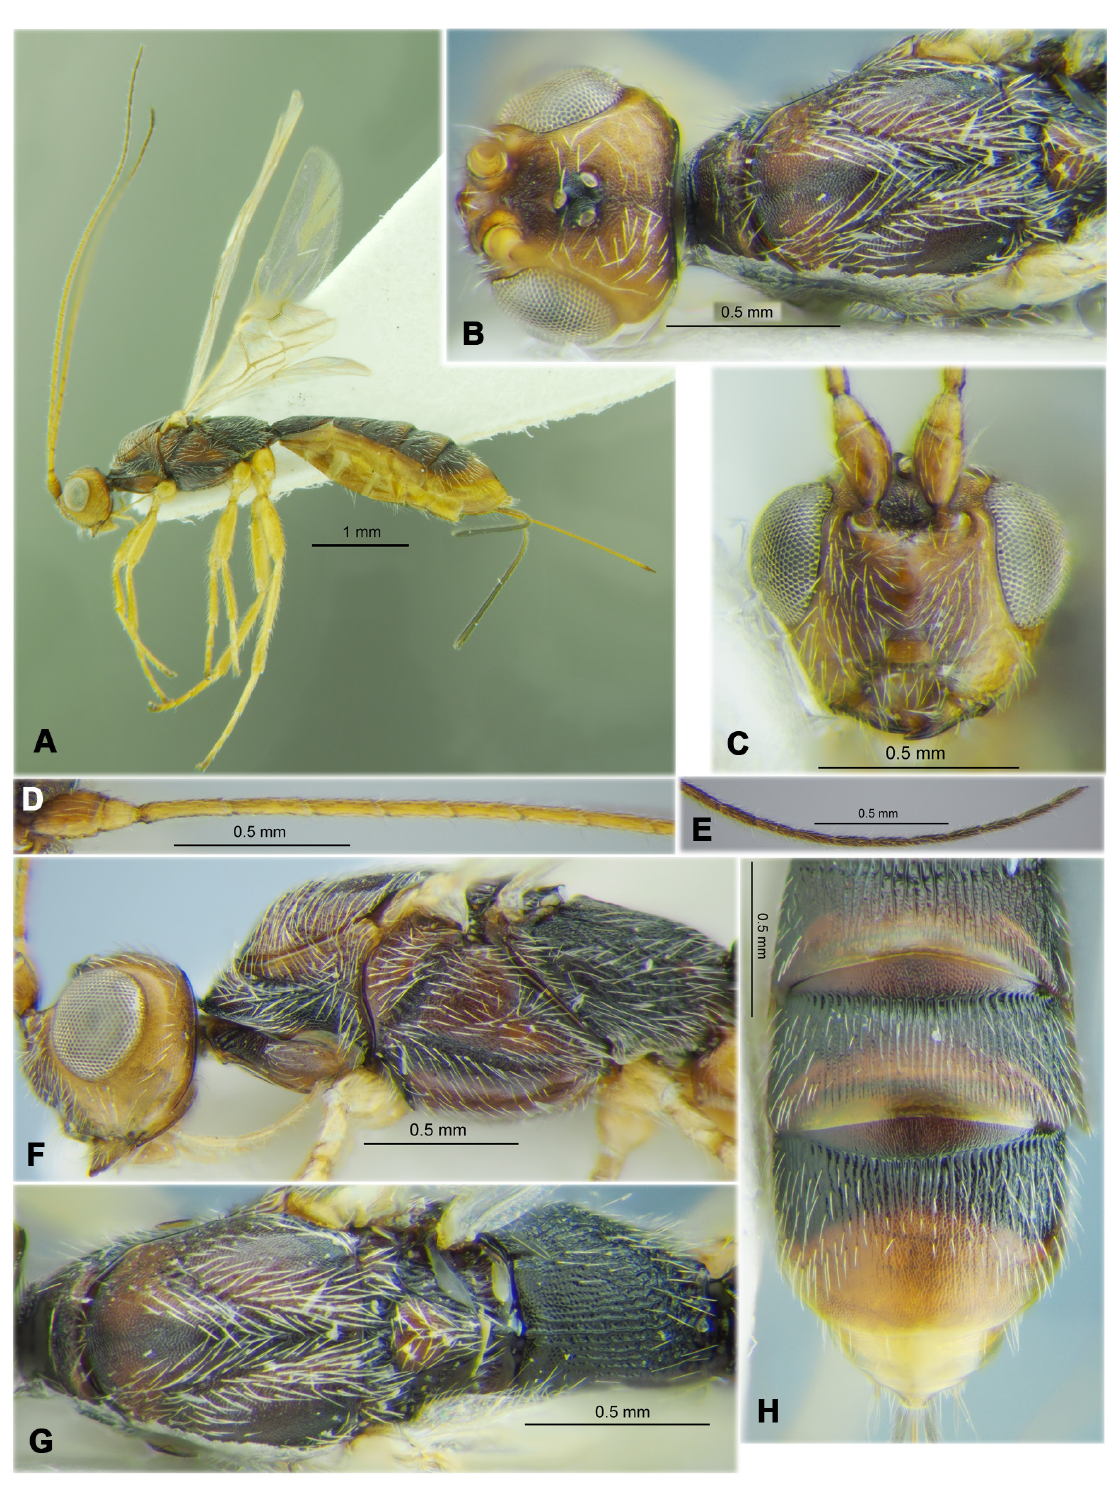
Fig. 59. Rhaconotus ( Rh. ) sudanensis Wilkinson, 1927, ♀ (RMNH). A . Habitus, lateral view. B . Head and mesoscutum, dorsal view. C . Head, front view. D . Basal segments of antenna. E . Apical segments of antenna. F . Head and mesosoma, lateral view. G . Mesosoma, dorsal view. H . Third to fifth metasomal tergites, dorsal